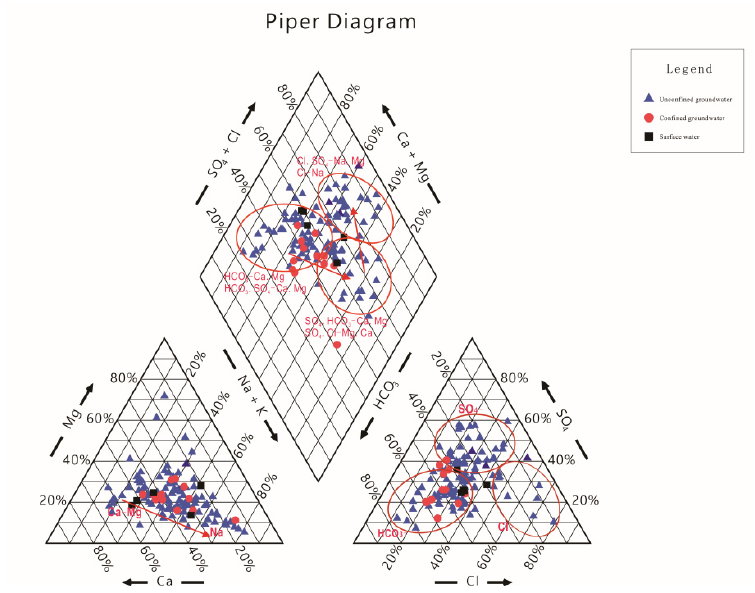
Figure 3. Piper diagram of all groundwater and surface water samples.